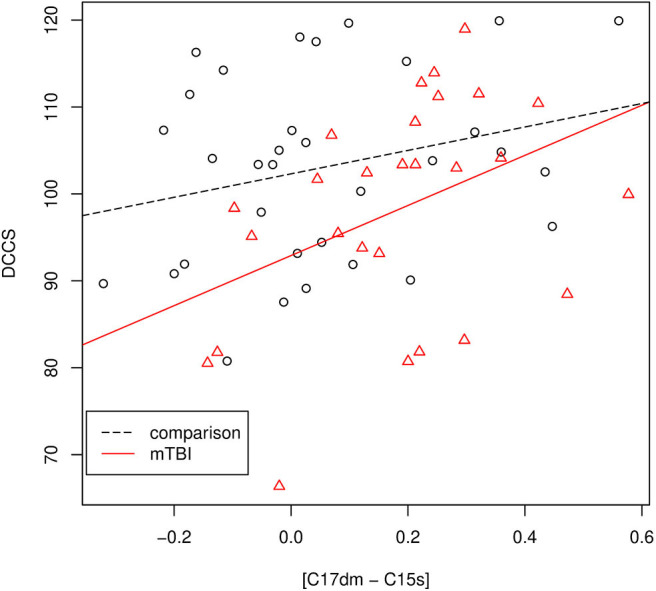
The association between the DCCS score and [C17dm – C15s]. Data points with circle shape are controls and data points with triangle shape are mTBI patients.